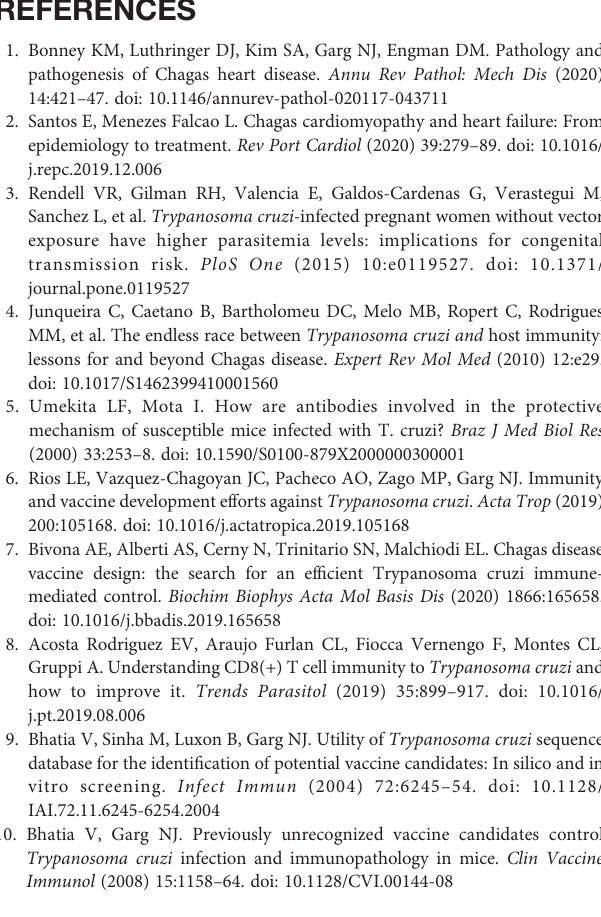
SUPPLEMENTARY FIGURE 3 | Effect of re-challenge on dynamics of T cell sub- populations in acutely infected mice (± vaccine). C57BL/6 mice were immunized with two doses of p2/4 or nano2/4 at 21 days interval, infected on day 21 after 2 nd vaccine dose, re-challenged on day 21 after fi rst infection, and euthanized on day 7 after re-challenge, as described in Figure 4A . Splenocytes were labeled with fl uorescent-conjugated antibodies and analyzed by fl ow cytometry. FlowSOM analysis of CD3 + splenic T cells of mice based on the expression levels of CD4, CD8, CD25, CD62L, and CD44 antigens generated self-organizing ten meta- clusters (referred as P0 – P9). (A) Mean percentages of P0 – P9 sub-populations of T cells in control, T. cruzi only, p2/4. Tc and nano2/4 .Tc groups of mice at 21 days after 1 st infection and 7 days after re-challenge are shown. (B – D) Median fl uorescent intensity was calculated for IFN- g , perforin (PFN) and granzyme B (GZB) in T effector/effector memory (T EM ) and T central memory (T CM ) subsets. All data are derived from n ≥ 5 mice per group (at least duplicate observations per